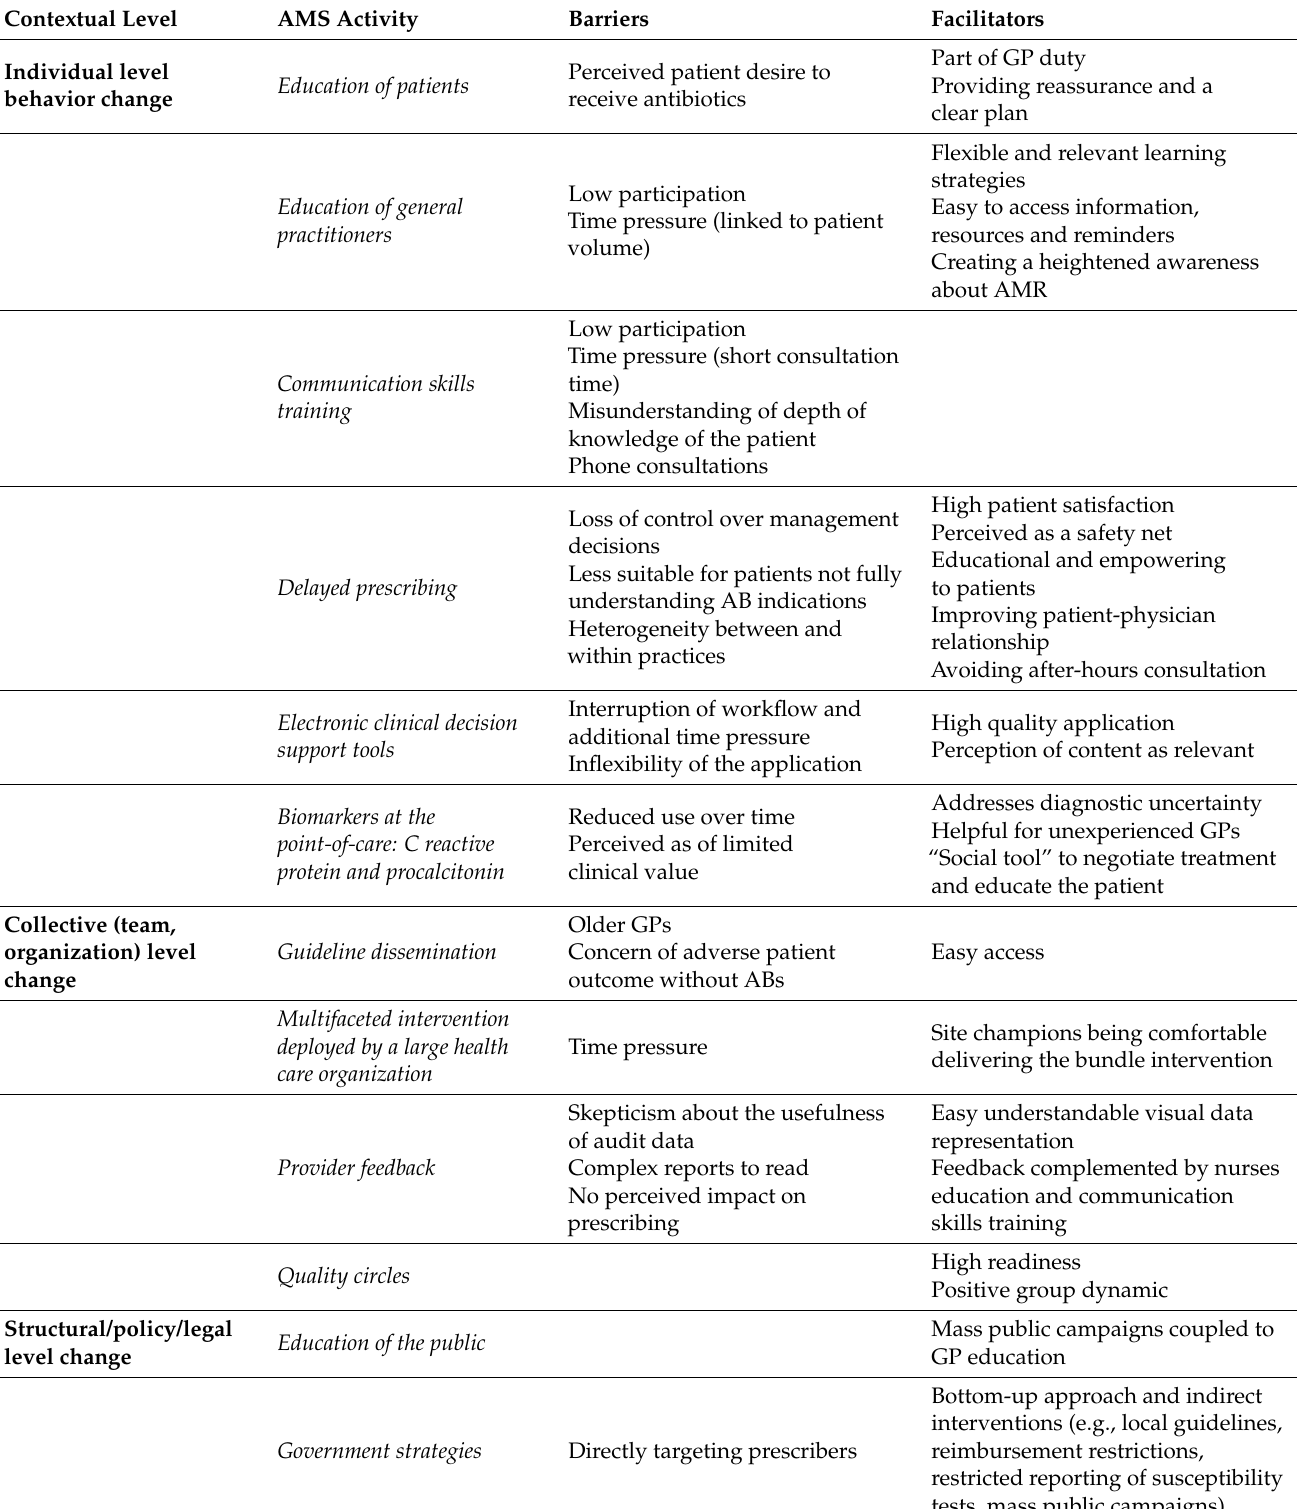
Table 2. Summary of barriers and facilitators influencing the implementation of AMS